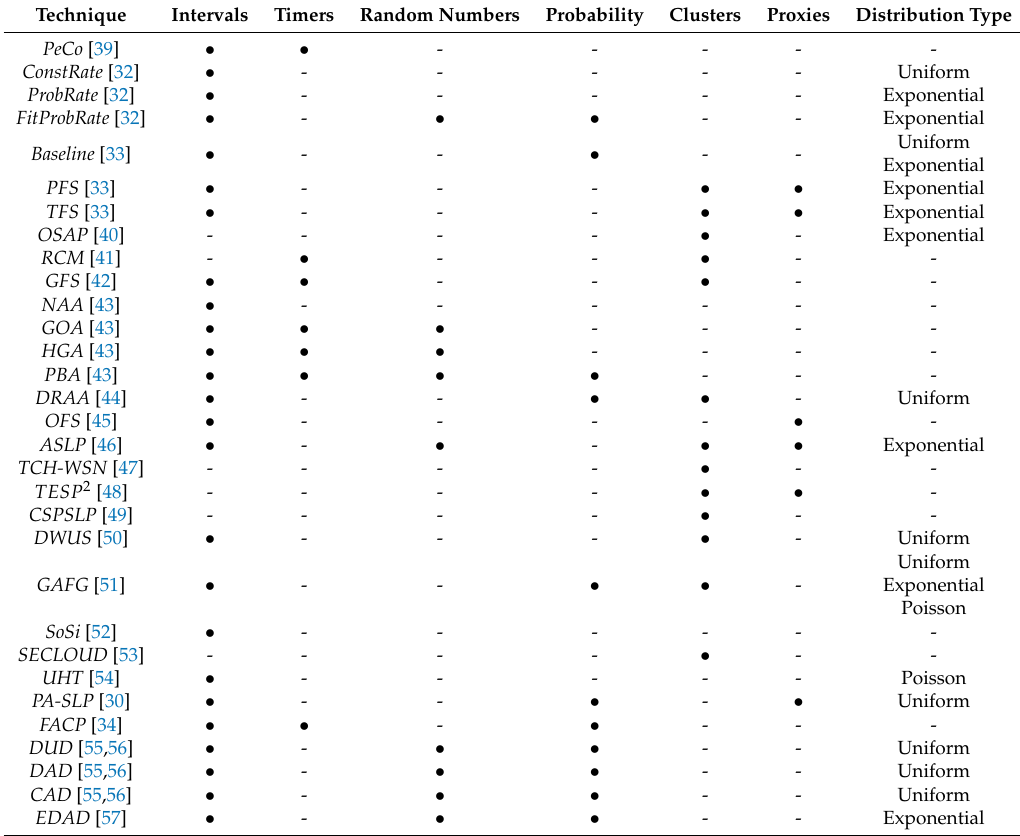
Table 1. Comparison of fake packet